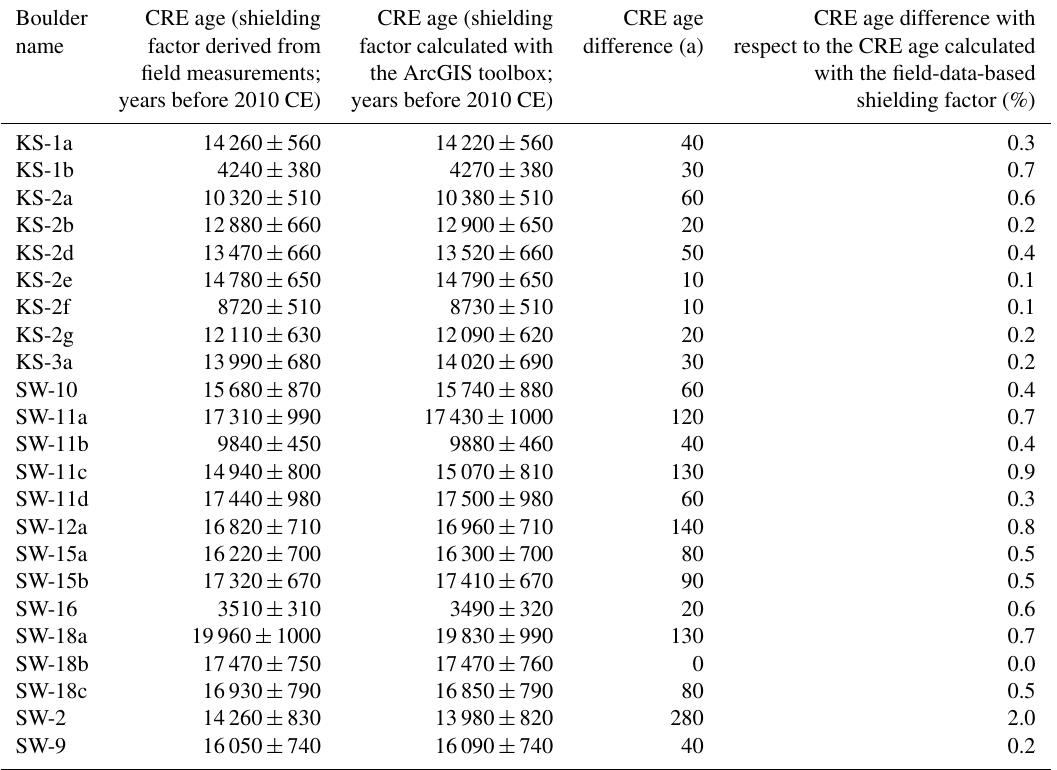
Table B1. CRE ages of boulders on moraines in Sankt Wilhelmer Tal. The ages have already been presented and interpreted elsewhere (Hofmann et al., 2022). They were first calculated with the CREp (Martin et al., 2017) with topographic shielding factors derived from field measurements and then with topographic shielding factors calculated with the ArcGIS-toolbox of Li (2018) and SRTM elevation data (NASA Jet Propulsion Laboratory,